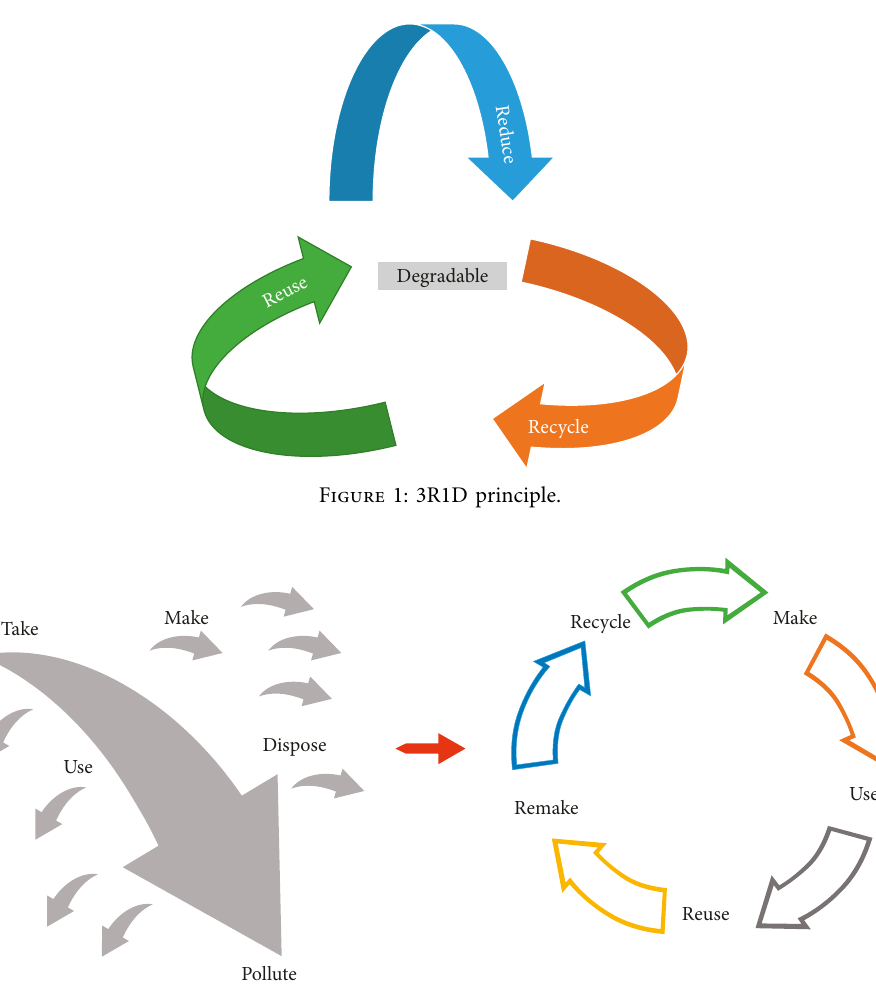
Figure 2: Green ecological